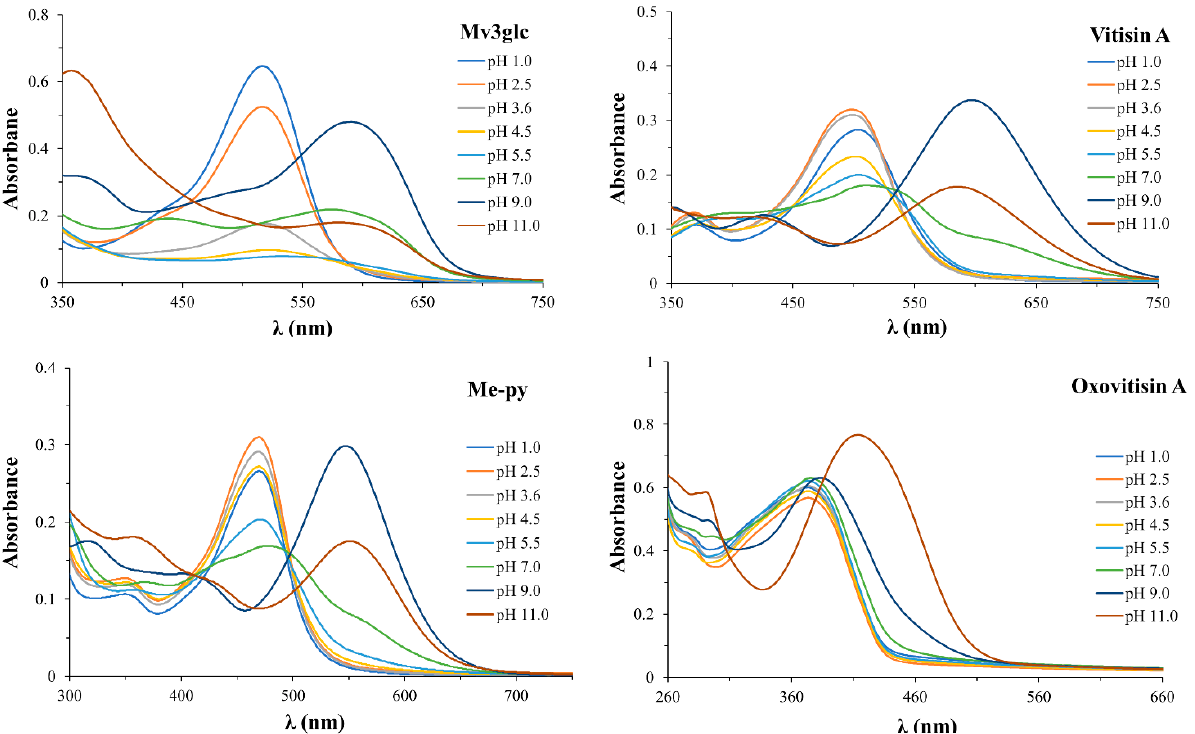
Figure 3. UV–VIS spectra of Mv3glc, vitisin A, Me-py, and oxovitisin A at different pH values (1.0–11.0).